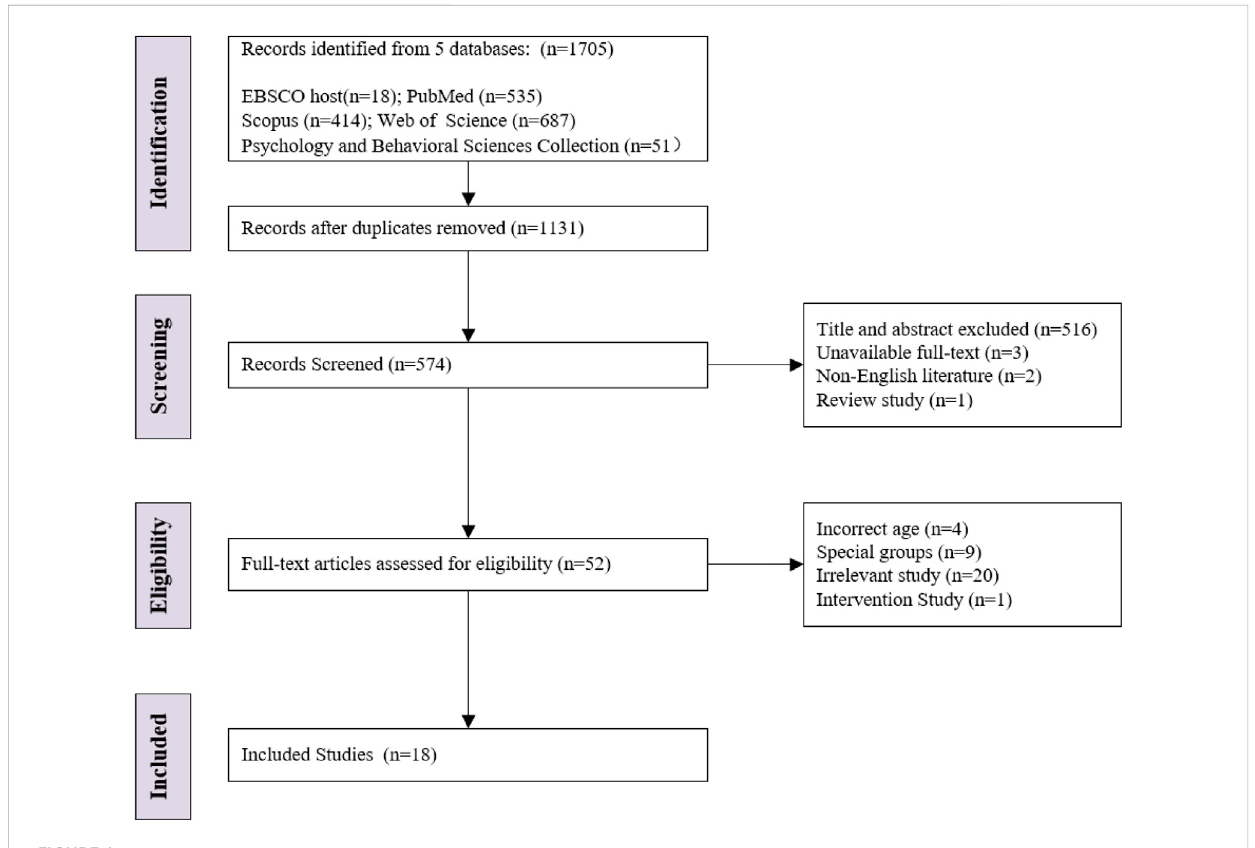
FIGURE 1 Flow diagram of the study selection